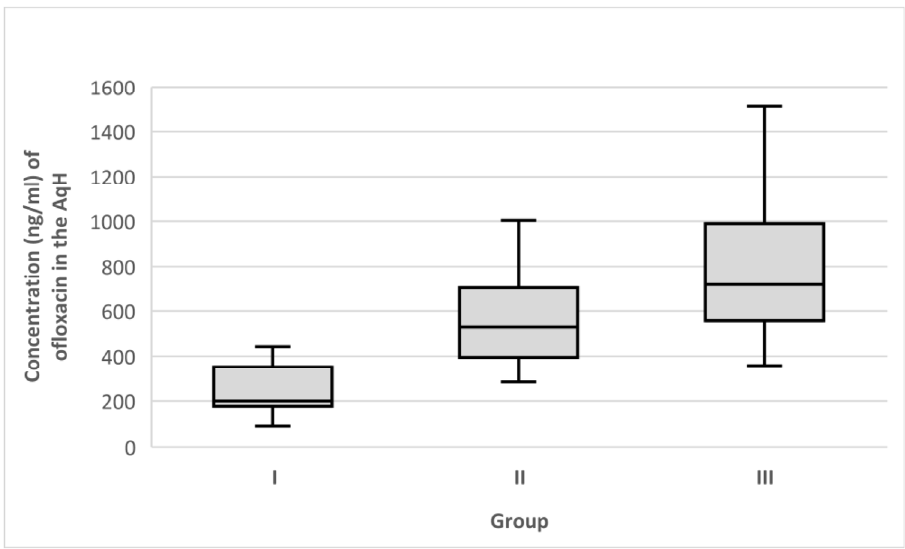
Figure 1. Median ofloxacin concentrations (ng/mL) in the AqH. Error bars represent the interquartile range. p < 0.001 (Kruskal–Wallis test) differences between group I and group II and groups I and III (pairwise comparisons). p = 0.02 differences between groups II and III (pairwise comparisons).